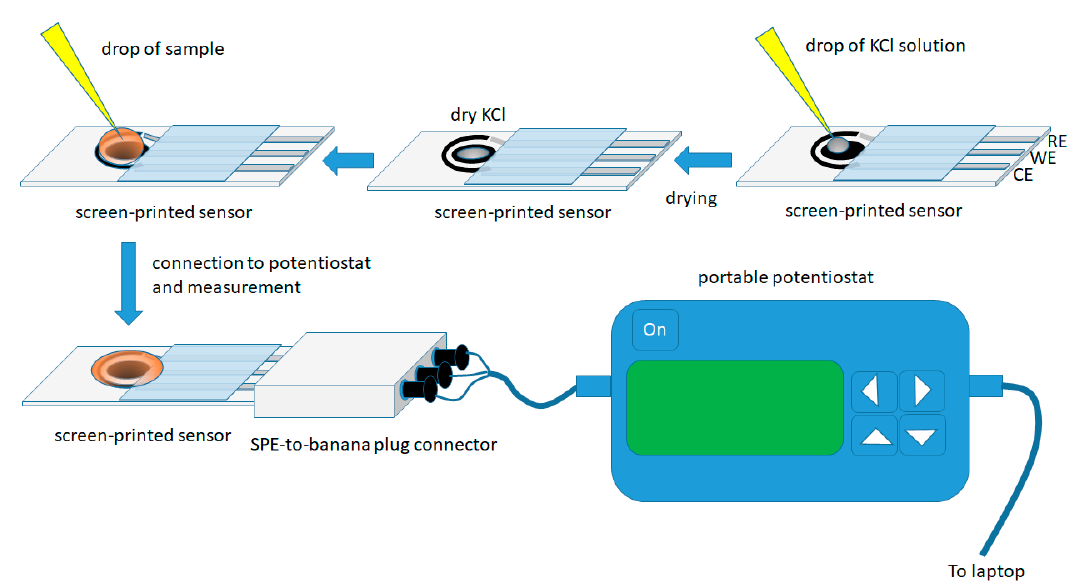
Figure 1. Experimental procedure for the determination of flunitrazepam in alcoholic beverages using the screen-printed sensor in the dry-reagent format.